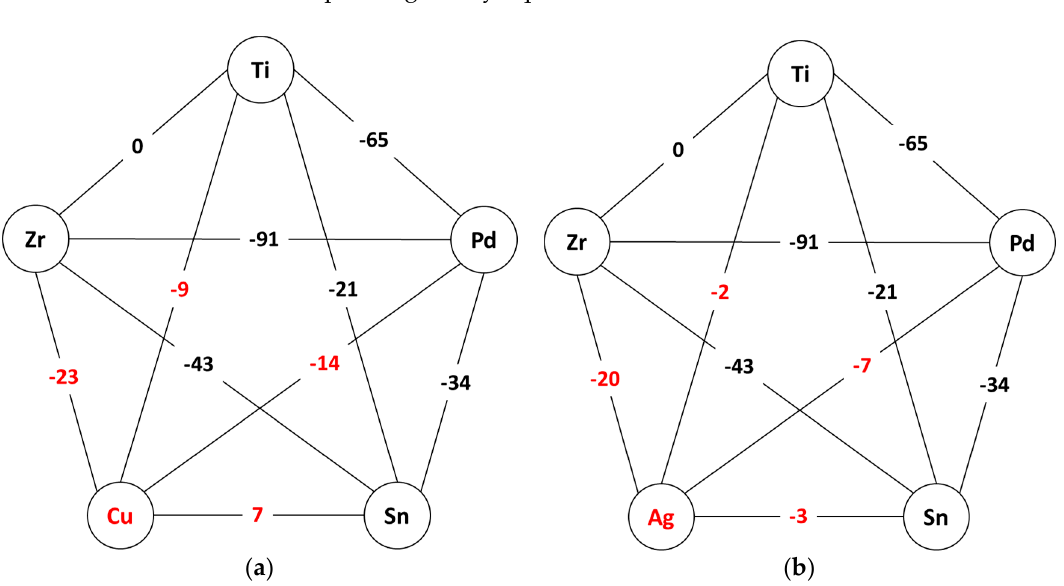
Figure 1. Mixing enthalpies ∆ H mix between the atomic pairs of the alloy constituents (in kJ/mol), emphasizing ( a ) Cu-containing alloy; and ( b ) Ag-containing alloy.